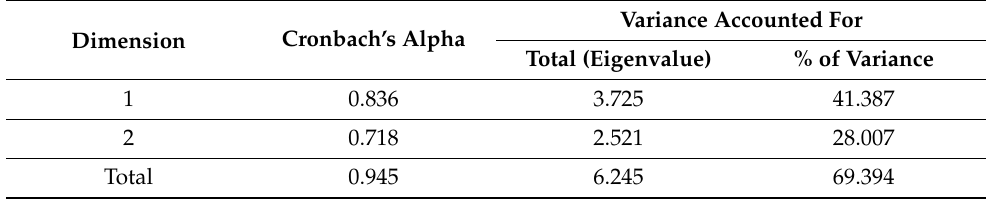
Table 5. Rotated data extraction for categorical PCA with 2